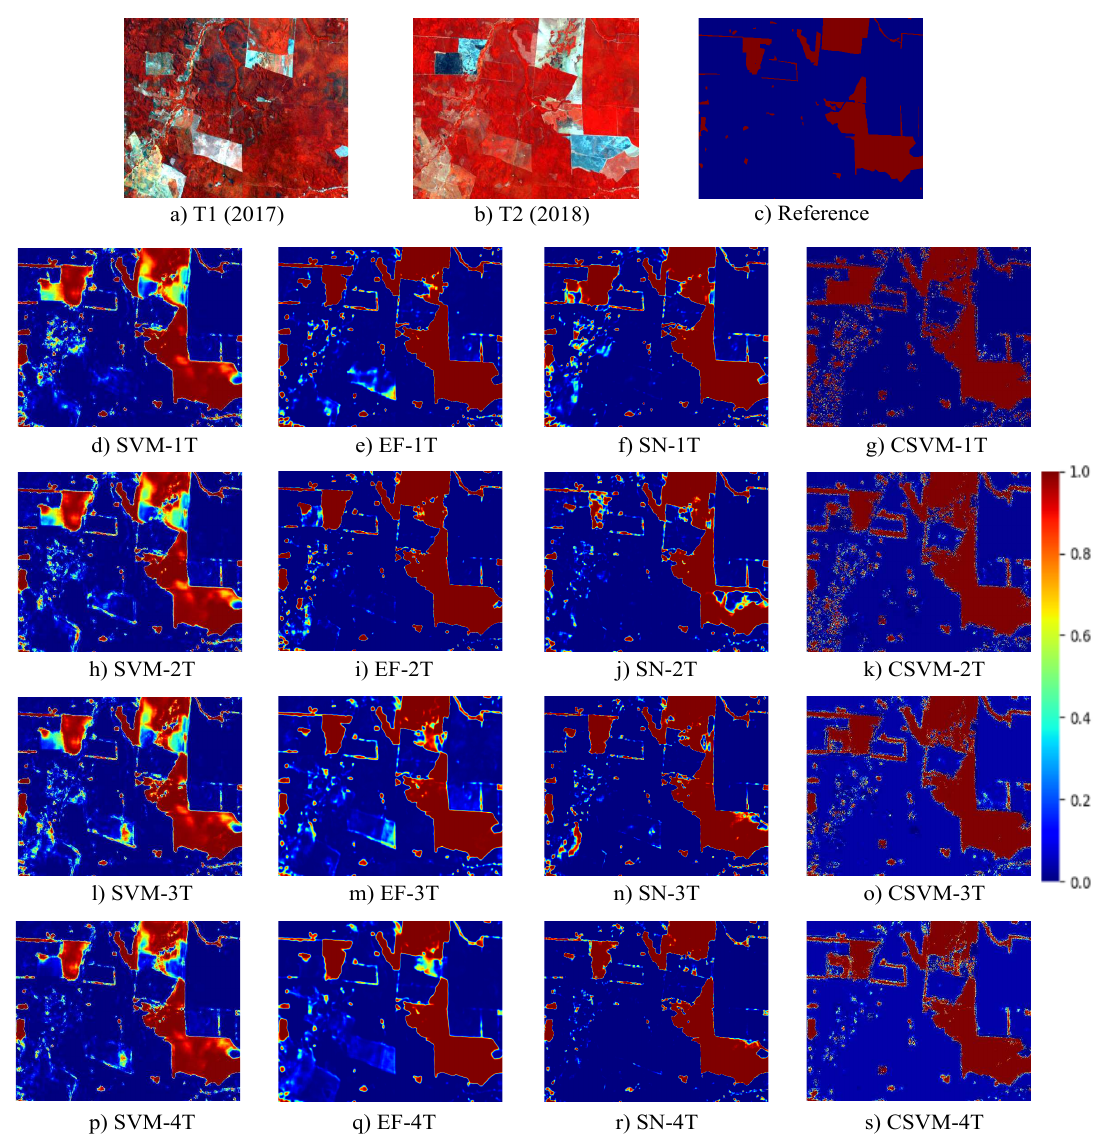
Figure 20. Predicted maps tile 8 produced by SVM, EF, SN, and CSVM using one, two, three, and four tiles for